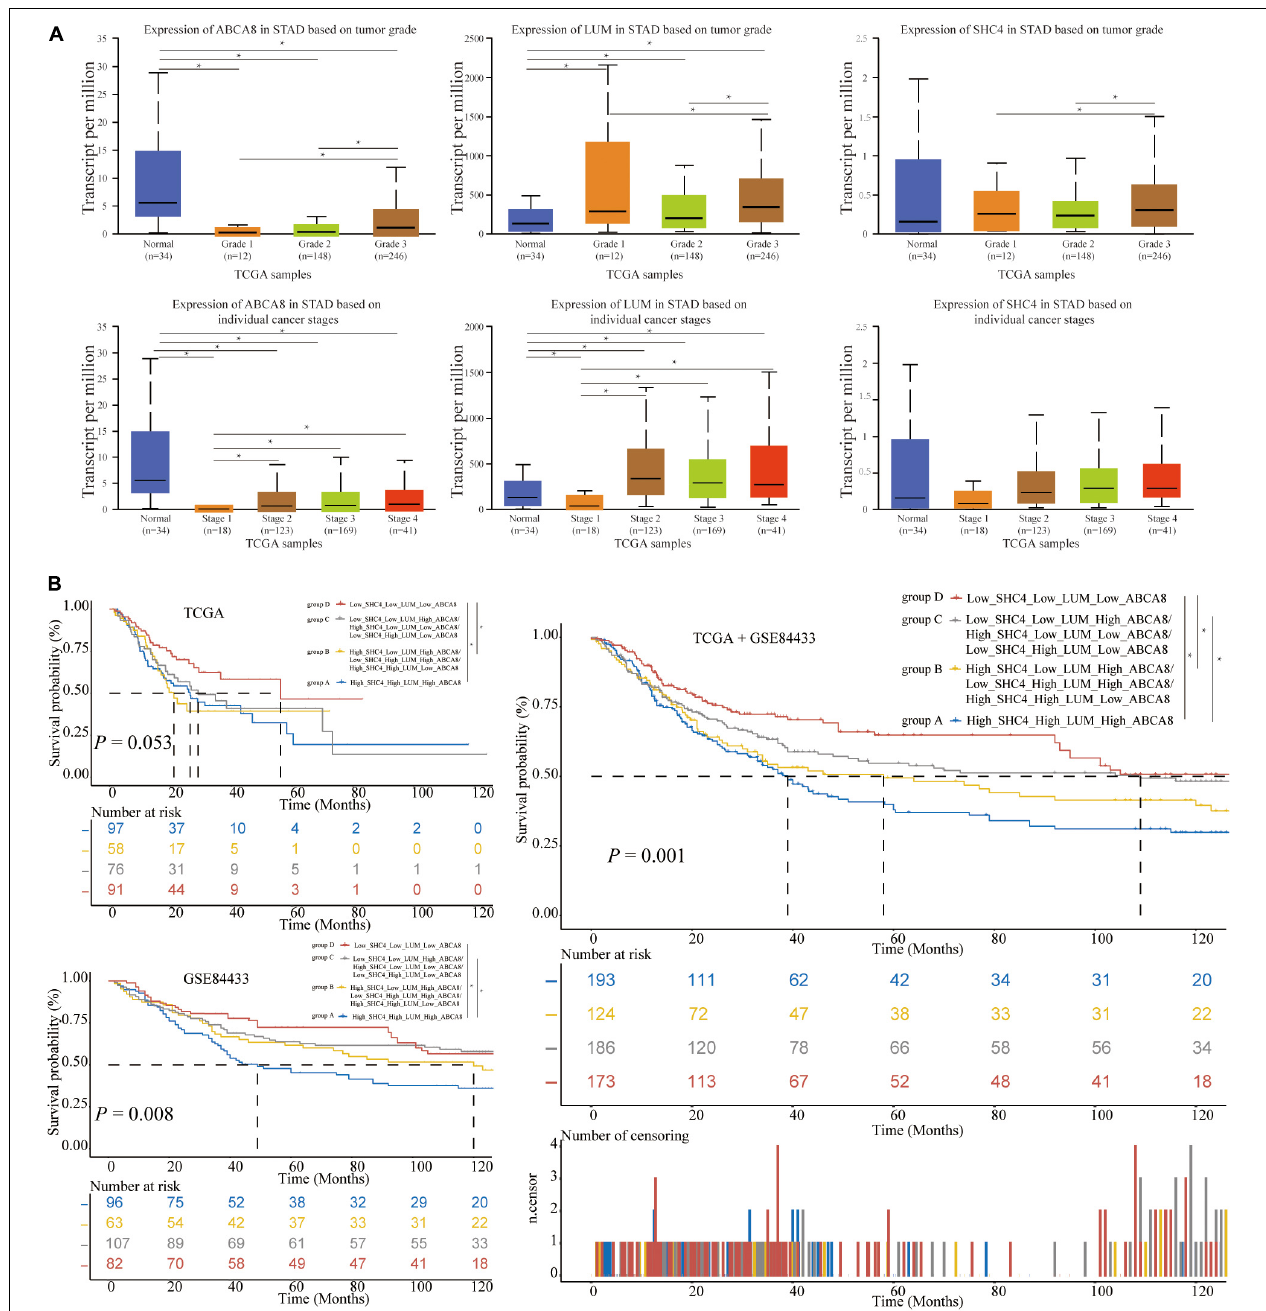
FIGURE 8 | The expression of 3 key genes among different grades and stages, and the construction of 3-gene signature. (A) In terms of grades, the higher the STAD patient’s grade, the higher the expression of 3 key genes. In the aspect of stages, the higher the STAD patient’s stage, the higher the expression of ABCA8 and LUM. (B) Based on the respective medians of 3 key genes, we divided the STAD patients of TCGA and GSE84433 into 4 groups. The more up-regulated genes in 3 key genes, the shorter the OS of STAD patients. The significant difference threshold was 0.05. * p < 0.05.